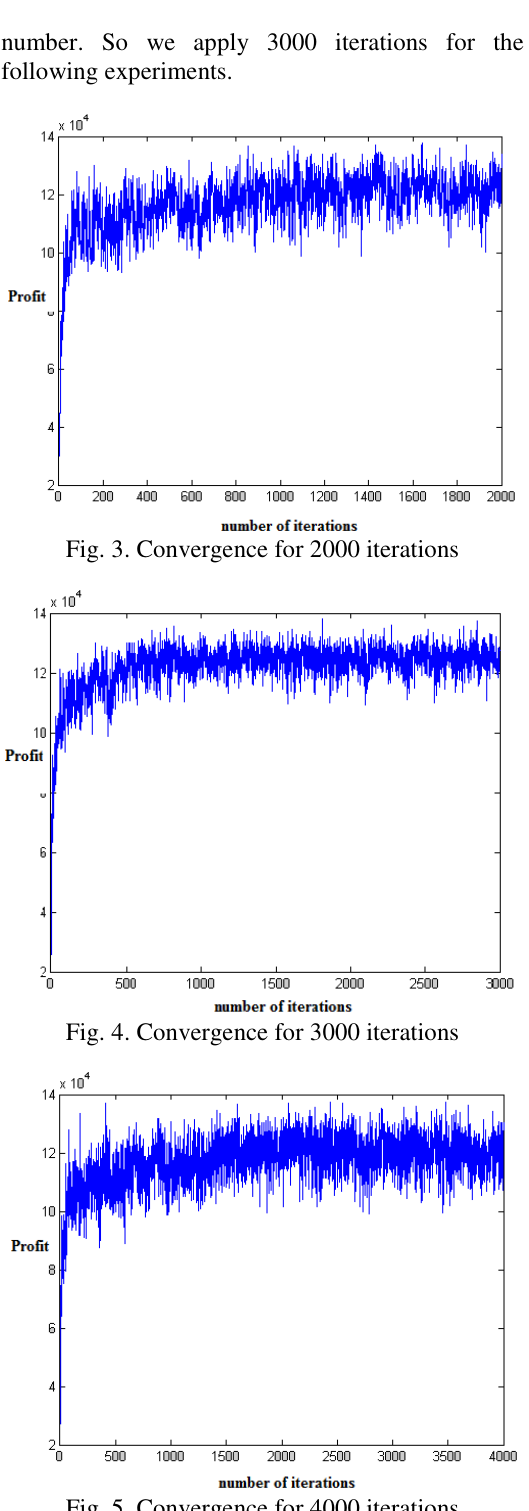
Fig. 5. Convergence for 4000